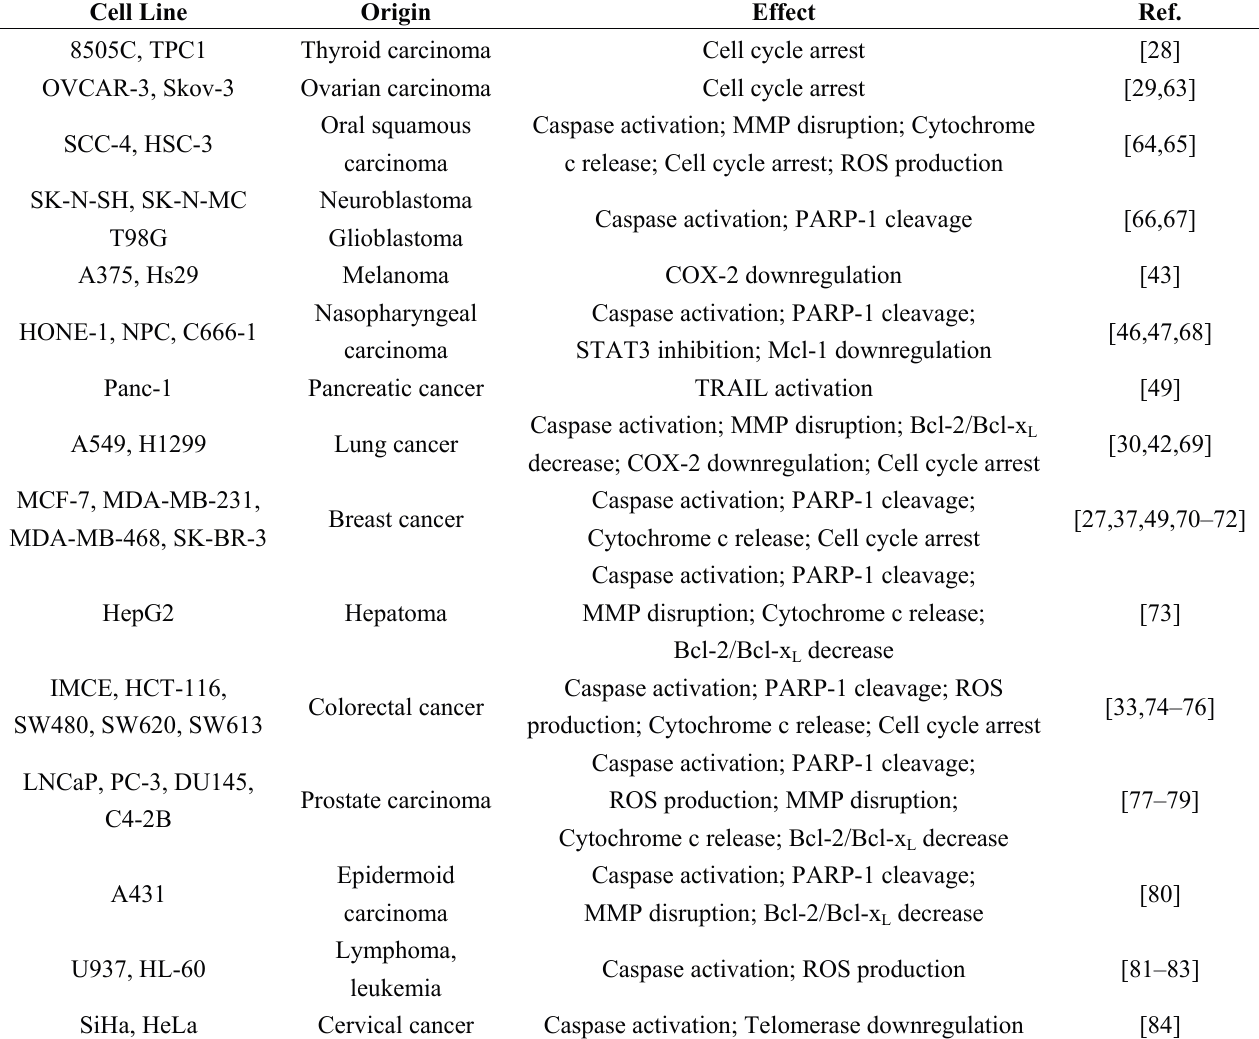
Table 1. Examples of the multiple effects of BBR leading to apoptosis in different cancer cell lines. Cell